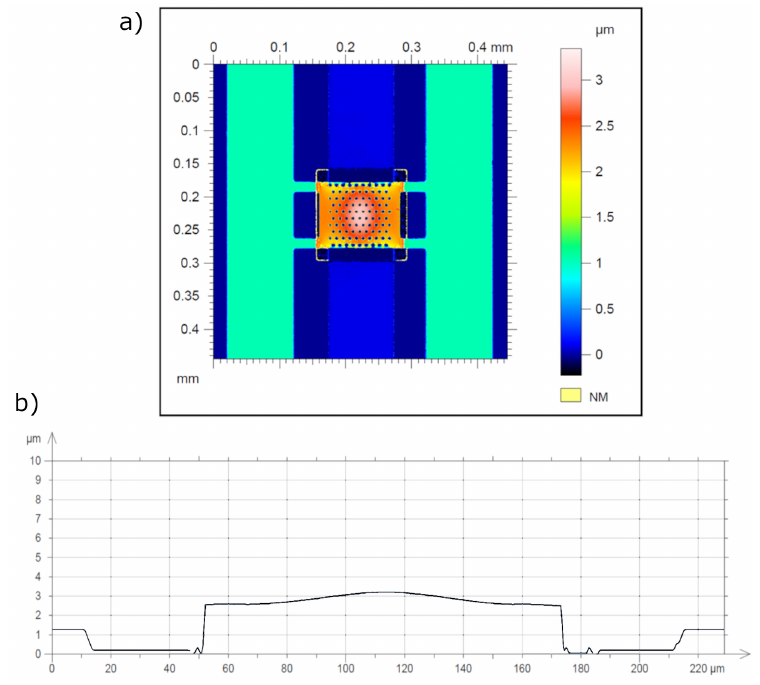
Figure 4. 2D membrane profile: ( a ) profile of the membrane surface, obtained on a Talysurf CCI2000 optical profilometer; ( b ) cross-section of the profile in the center from left to